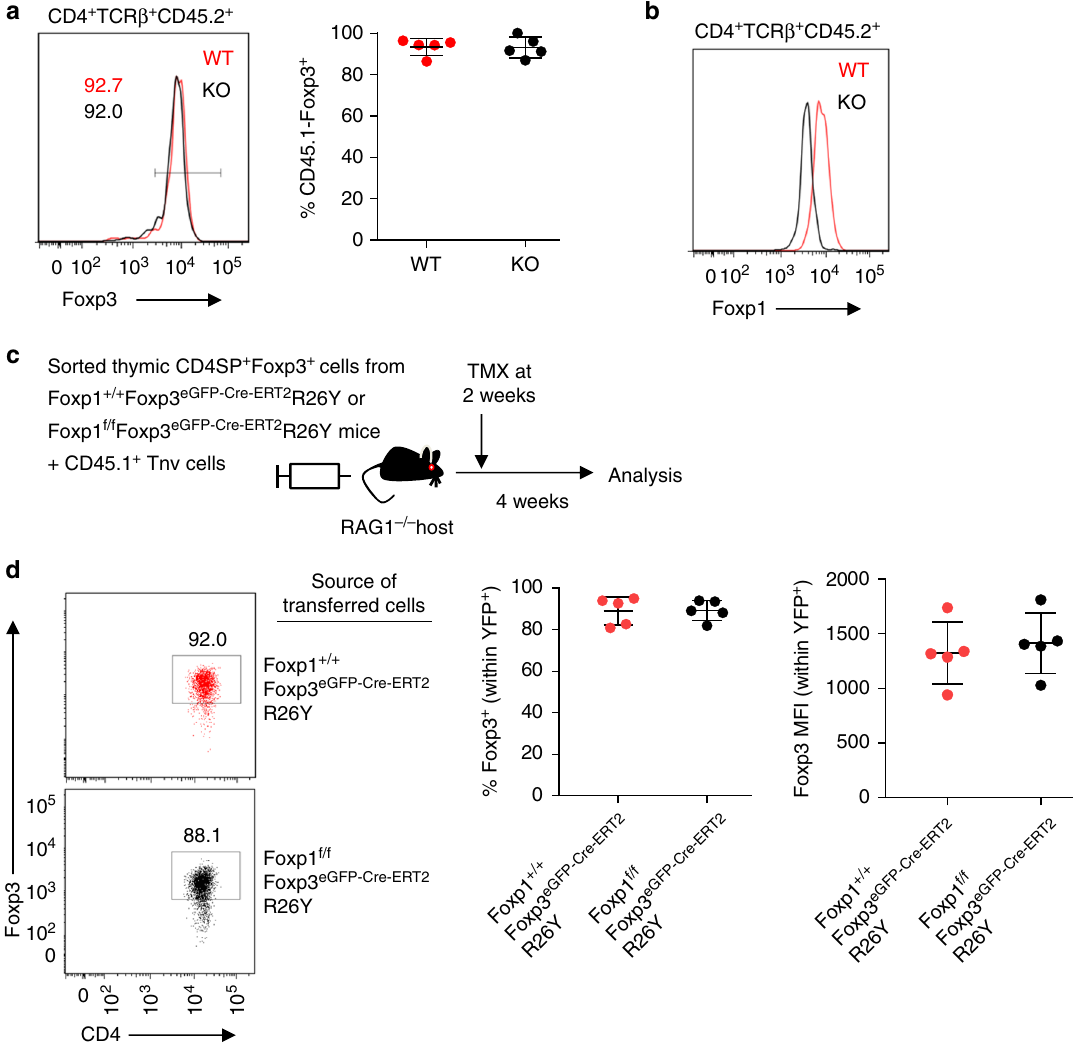
Fig. 3 Foxp1 is dispensable for maintenance of Foxp3 expression in tTreg cells. a WT or KO CD4SPFoxp3 + tTreg cells were sorted directly from thymus at high purity and co-transferred in RAG1 − / − hosts along with allelically marked CD4 + T cells derived from CD45.1 + Foxp3 GFPKO mice. Stability of Foxp3 expression was analyzed after 7 days post transfer. Representative histograms (left) and quanti fi cation plot (right) are shown from lymph nodes of recipient mice. b Representative intracellular staining showing Foxp1 protein expression in transferred WT and KO tTreg cells at the time of analysis. c Experimental scheme for acute depletion of Foxp1 in tTreg cells. FACS-sorted CD4SPFoxp3 + tTreg cells from thymus of Foxp1 + / + Foxp3 eGFP-Cre-ERT2 R26Y or Foxp1 f/f Foxp3 eGFP-Cre-ERT2 R26Y mice were co-transferred with CD4 + cells sorted from CD45.1 + Foxp3 GFPKO mice into RAG1 − / − recipients. Mice received tamoxifen at 2 weeks post transfer and stability of Foxp3 expression among YFP + cells was assessed after 4 weeks. d Representative FACS plots